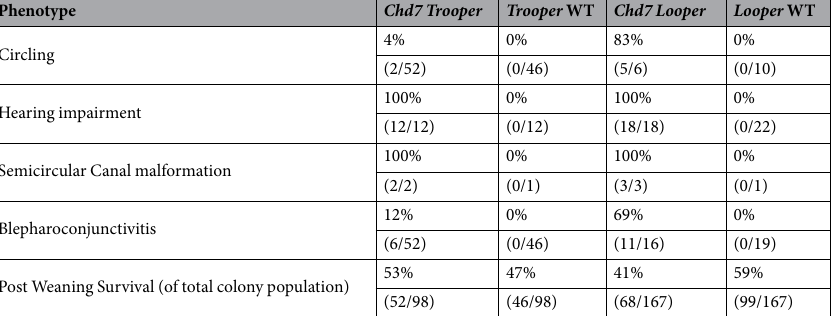
splice site positions. These markers define exon boundaries and lead to the recruitment of the spliceosome for intron removal. Multiple cryptic splice sites exist within precursor-mRNA’s, however they are not used unless the authentic splice site is interrupted by mutation. In rarer cases, such as the Trooper mutation, intronic de novo 3 ′ splice sites are activated by the creation of an AG marker in the polypyrimidine tract 21 . Generally, activated cryptic splice sites are within 100 nucleotides and upstream of the authentic splice site 22 . The Trooper mutation